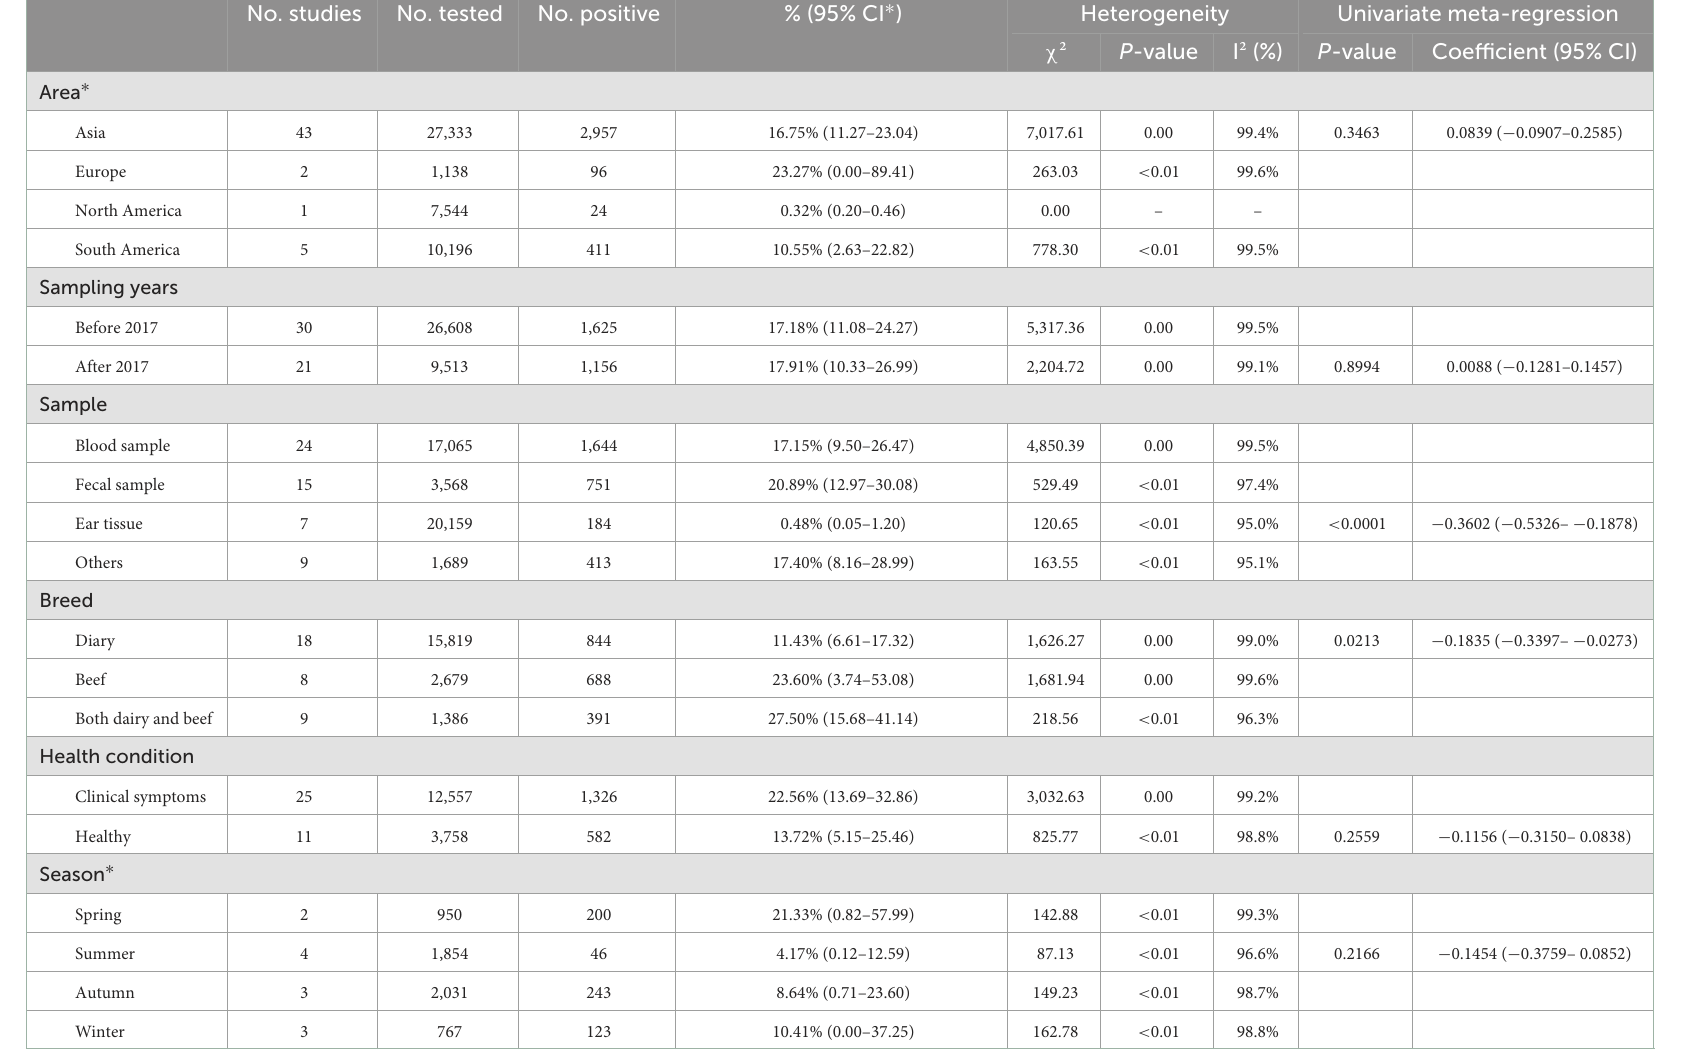
TABLE 2 Antigen prevalence of Bovine viral diarrhea virus of cattle in the word. No.